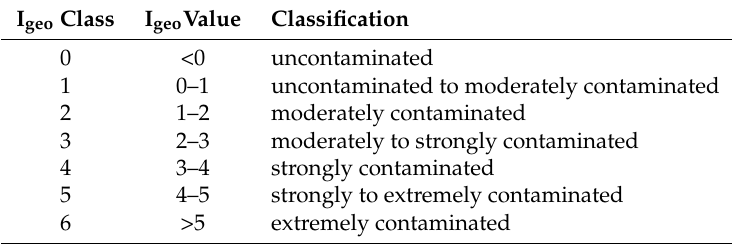
Table 4. Degree of metal pollution in terms of seven classes.